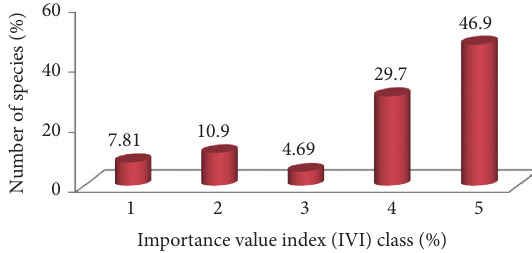
Figure 6: Importance value index class of tree and shrub species in Kafta Sheraro National Park. (1) > 15.1%, (2) 10.1–15.0%, (3)